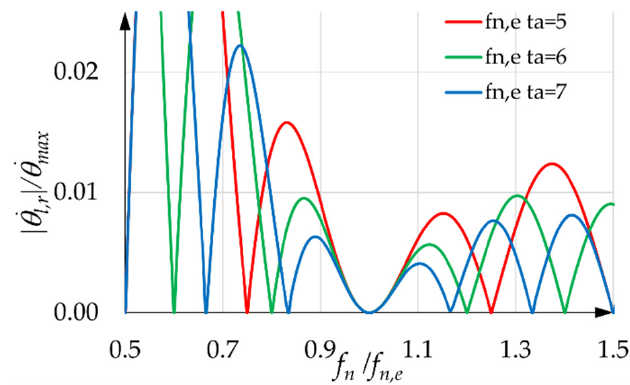
Figure 12. SCs with k j equal to one and f n , e t a equal to five, six, and seven.